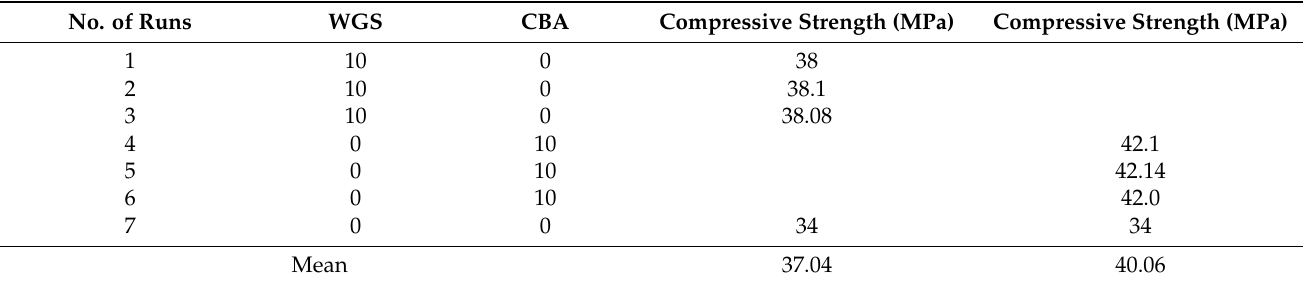
Table 7. Summary of optimization of